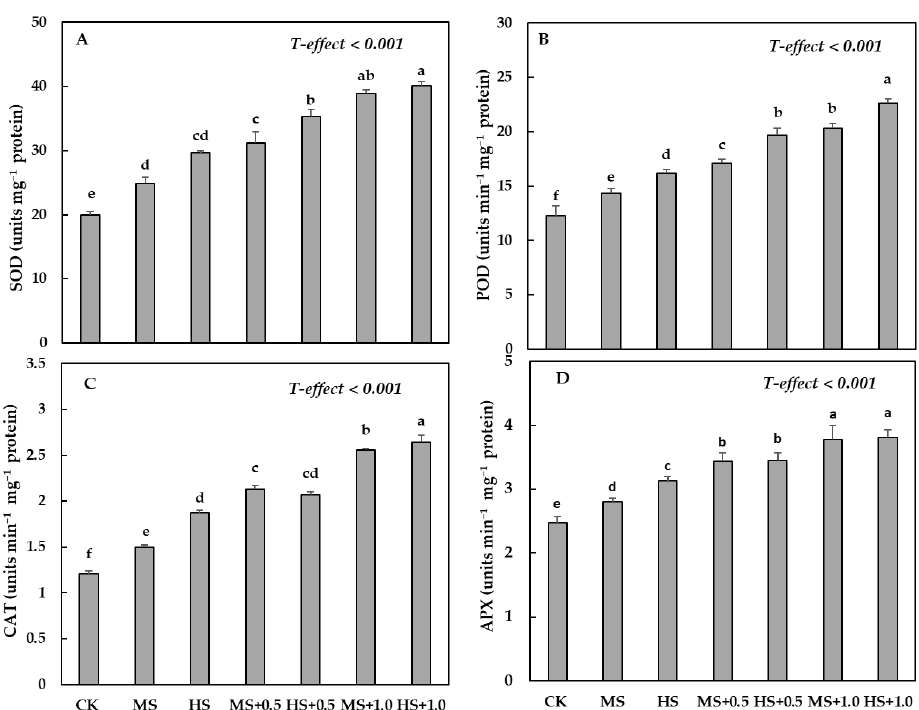
Figure 3. The average values of SOD ( A ), POD ( B ), CAT ( C ), and APX ( D ) under MS, HS, MS + 0.5, HS + 0.5, MS + 1.0 and HS + 1.0 treatments and foliar spray of SA in M. alba saplings. Small letters represent significant differences between treatment means at (T-effect) p < 0.05.